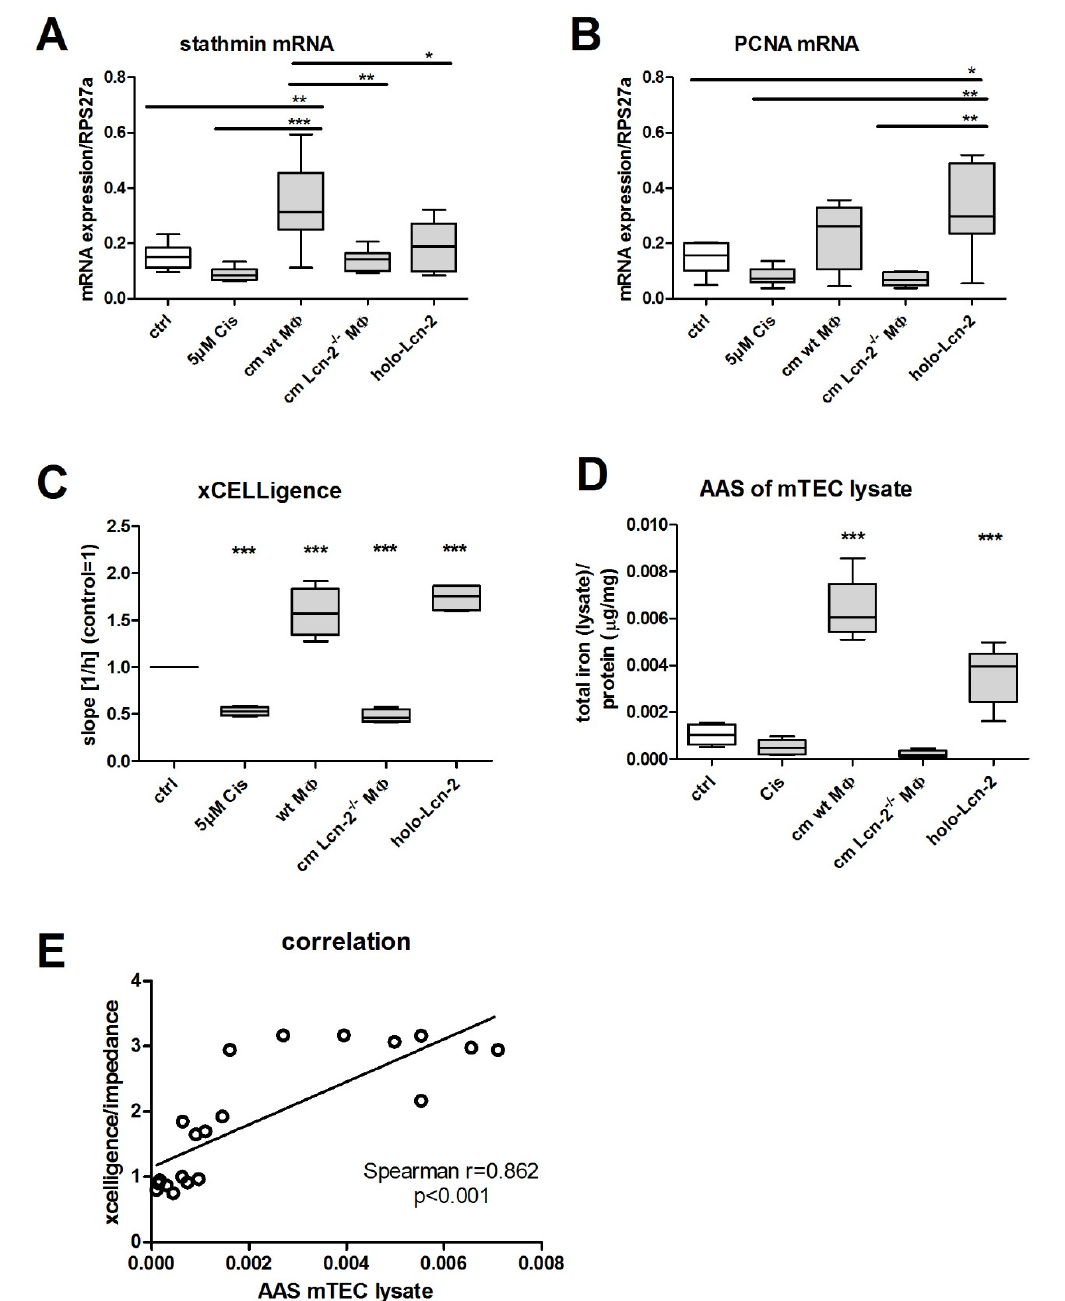
Figure 5. mTEC take up Lcn-2-bound iron that correlates with cellular proliferation. mRNA expression of ( A ) stathmin and ( B ) PCNA expression relative to the housekeeping gene RPS27a ( n = 6). ( C ) Measurement of real-time proliferation via xCELLigence ( p < 0.001; n = 5; one-way ANOVA followed by Tukey’s Multiple Comparison Test). ( D ) Measurement of total iron content in lysates of differently treated mTEC via AAS ( n = 6). * p < 0.05, ** p < 0.01, *** p < 0.001. ( E ) Correlation between total iron amount in mTEC lysates and proliferation (all values included; Spearman r = 0.862, p < 0.001).